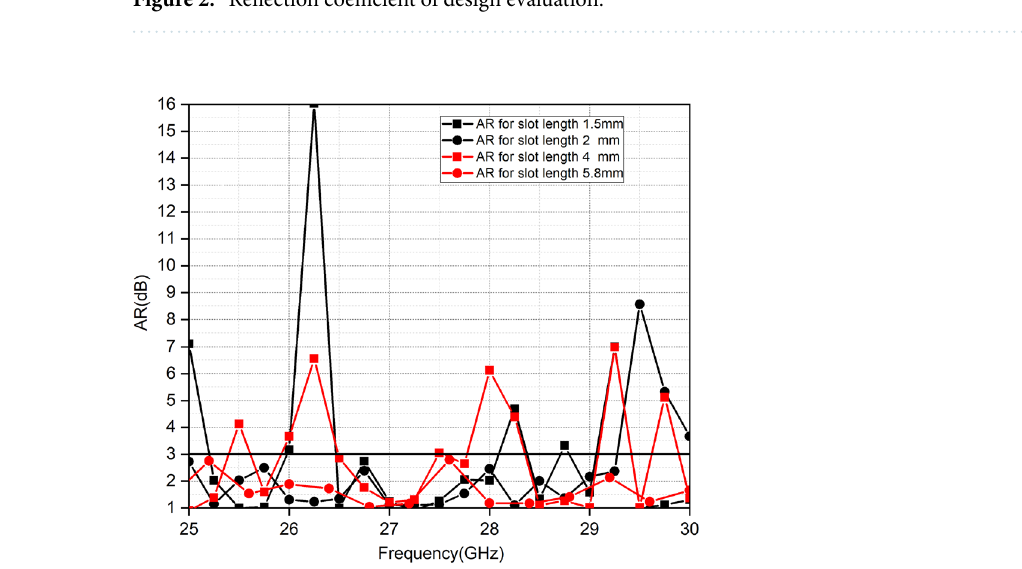
Figure 3. Parametric Analysis of the impact of slot length on AR.